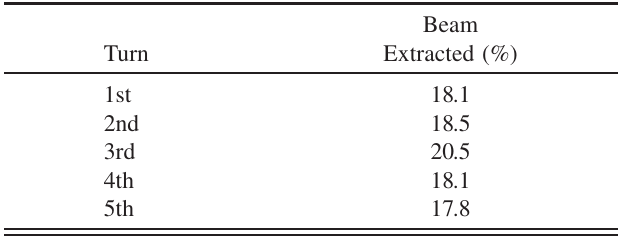
TABLE I. Extraction efficiency measurements for each of the five turns, with an overall average efficiency of (cid:3) 93% .